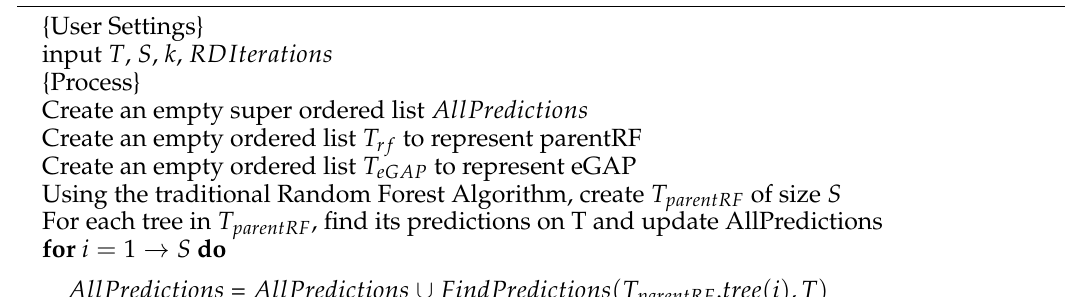
Algorithm 1 eGAP